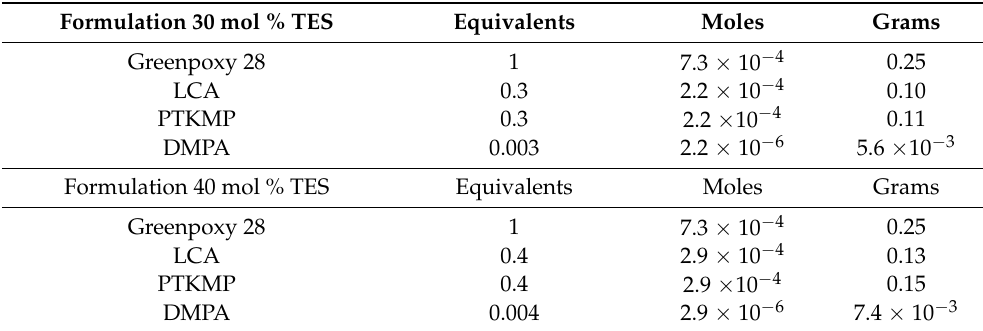
Table 1. Components of the epoxy/thiol-ene photocurable formulations with epoxy resin Greenpoxy 28, LCA, PTKMP and